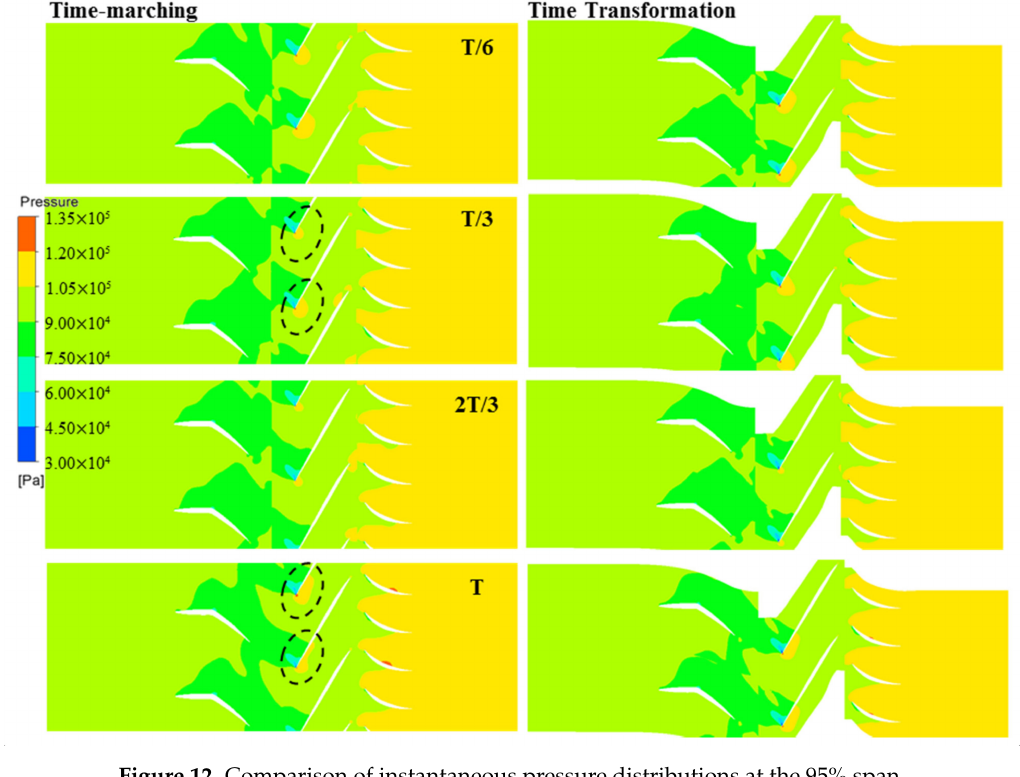
Figure 12. Comparison of instantaneous pressure distributions at the 95% span.